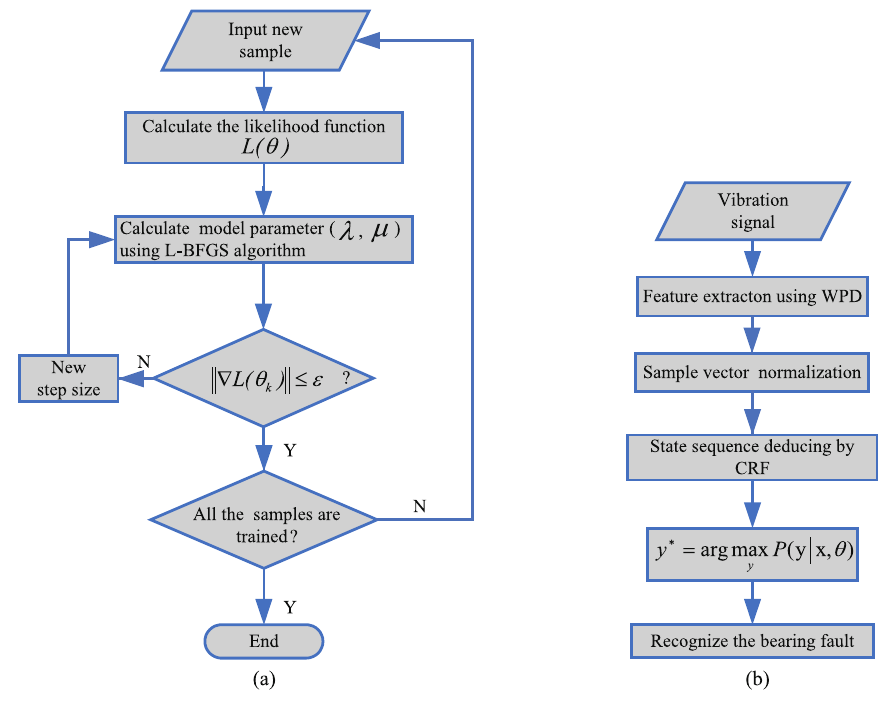
Fig. 2. Flowchart of CRF model parameters estimation and